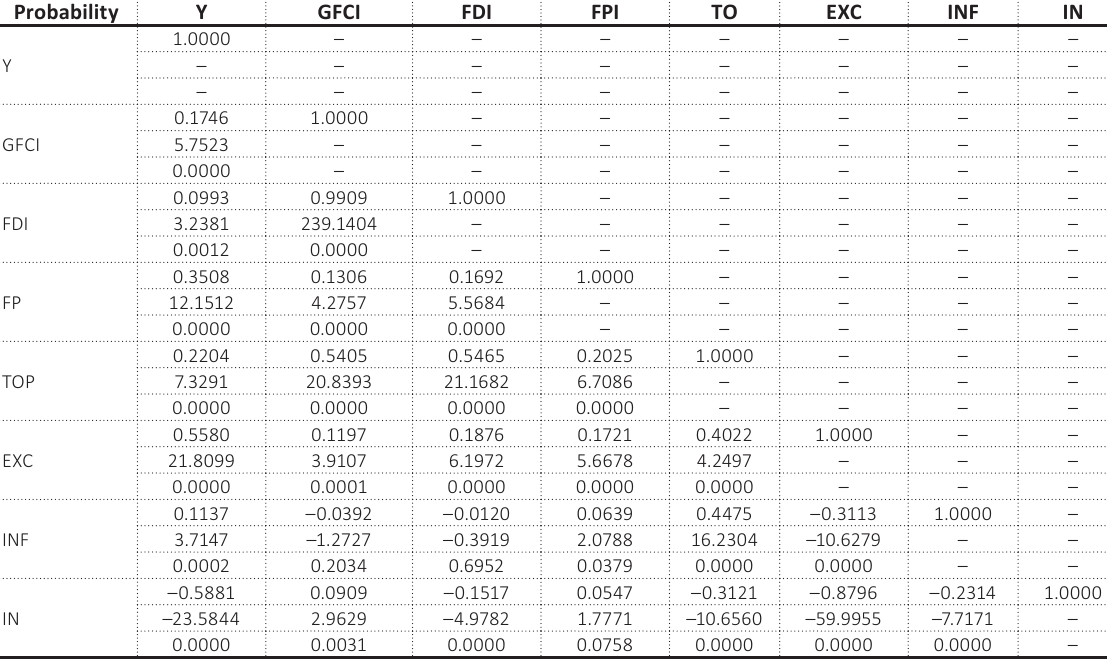
Table 3. LLC, IPS and Augmented ADF unit root